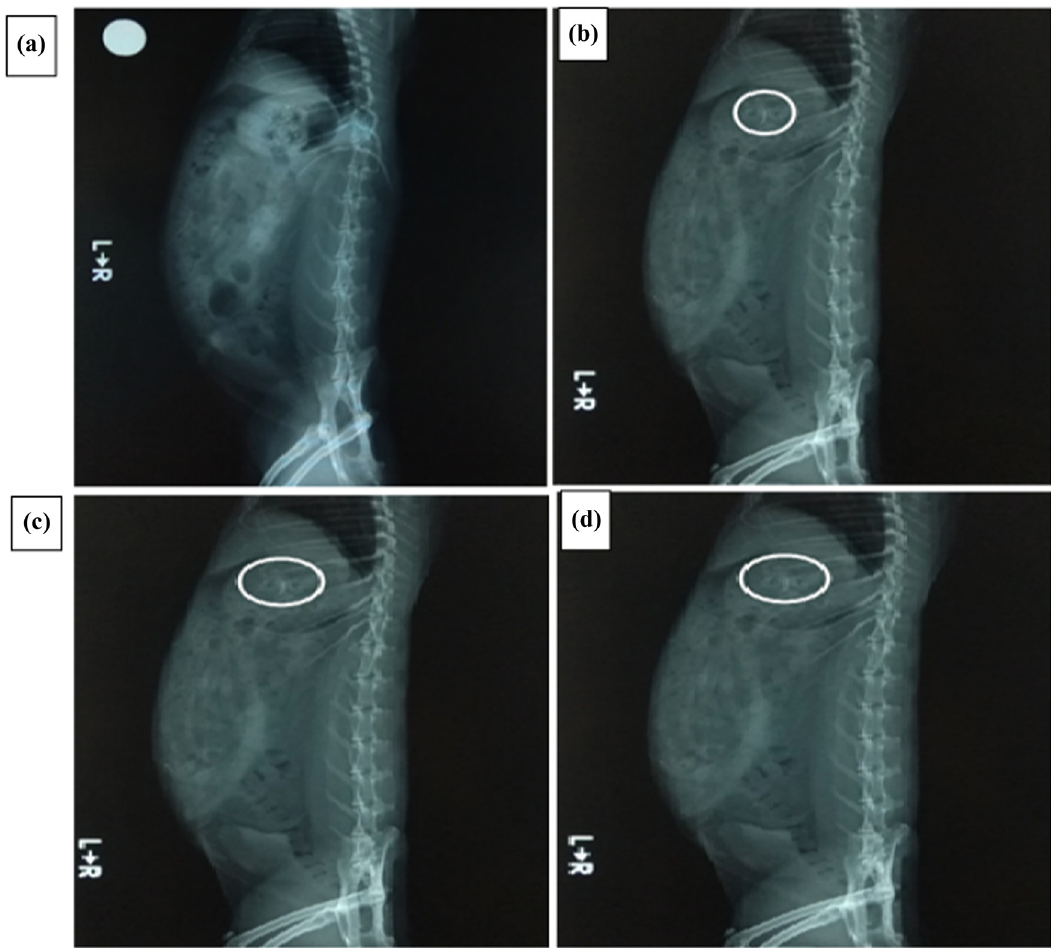
Figure 5: Radiographic images portraying the bilayer fl oating tablet containing barium sulfate as a radio opaque marker in the stomach of rabbits at 0 h ( a ) , 2 h ( b ) , 4 h ( c ) , and 6 h ( d ) ; the tablet is pointed by a